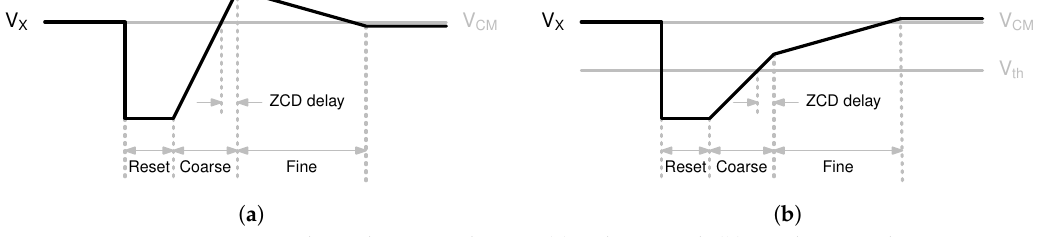
Figure 2. Two-phase charging schemes. ( a ) Bidirectional. ( b )